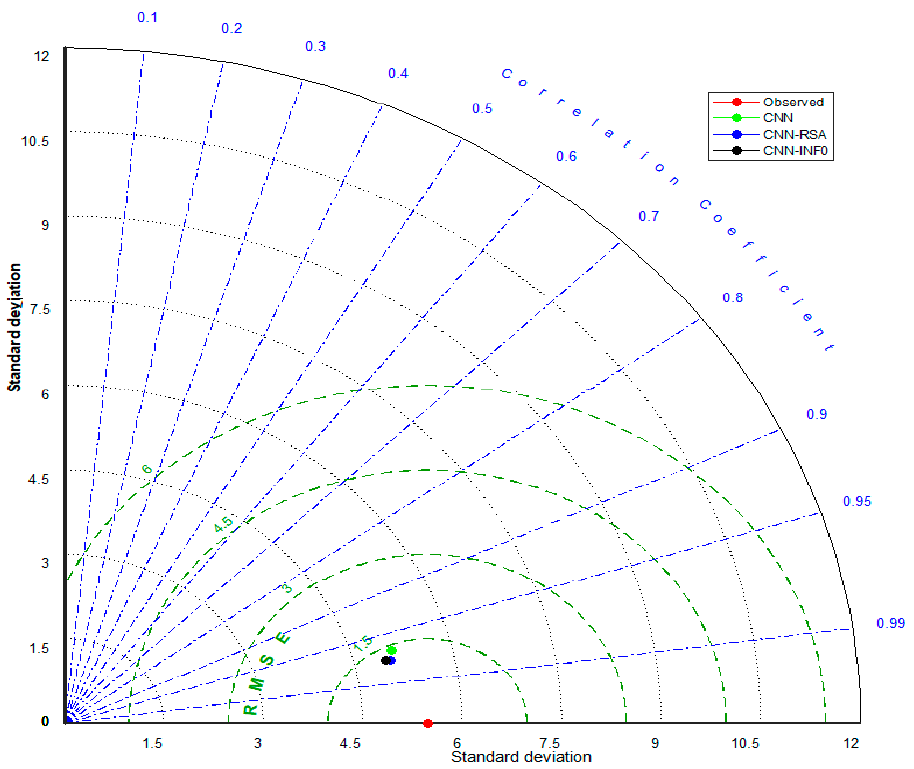
Figure 9. Taylor diagrams of the predicted water temperature using different CNN-based models in the test period with the best input